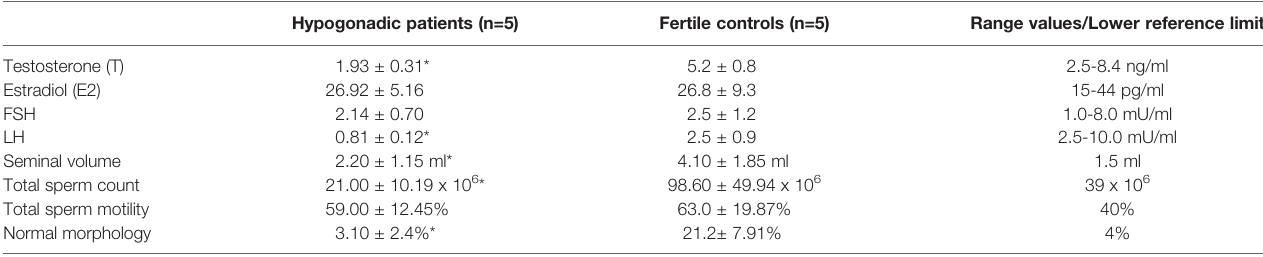
P-value < 0.05 is indicated in the table